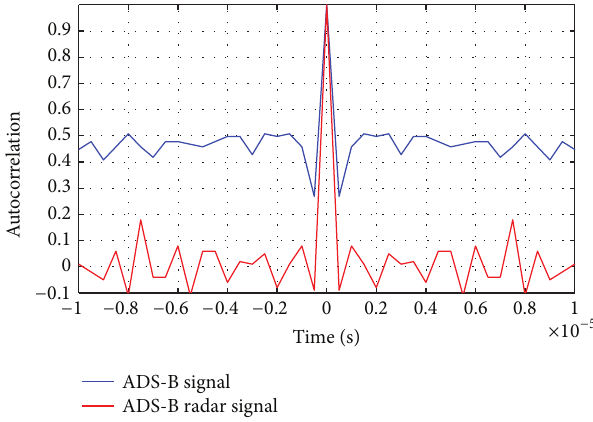
Figure 4: Autocorrelation of standard ADS-B signal and autocorre- lation of the ADS-B radar signal.